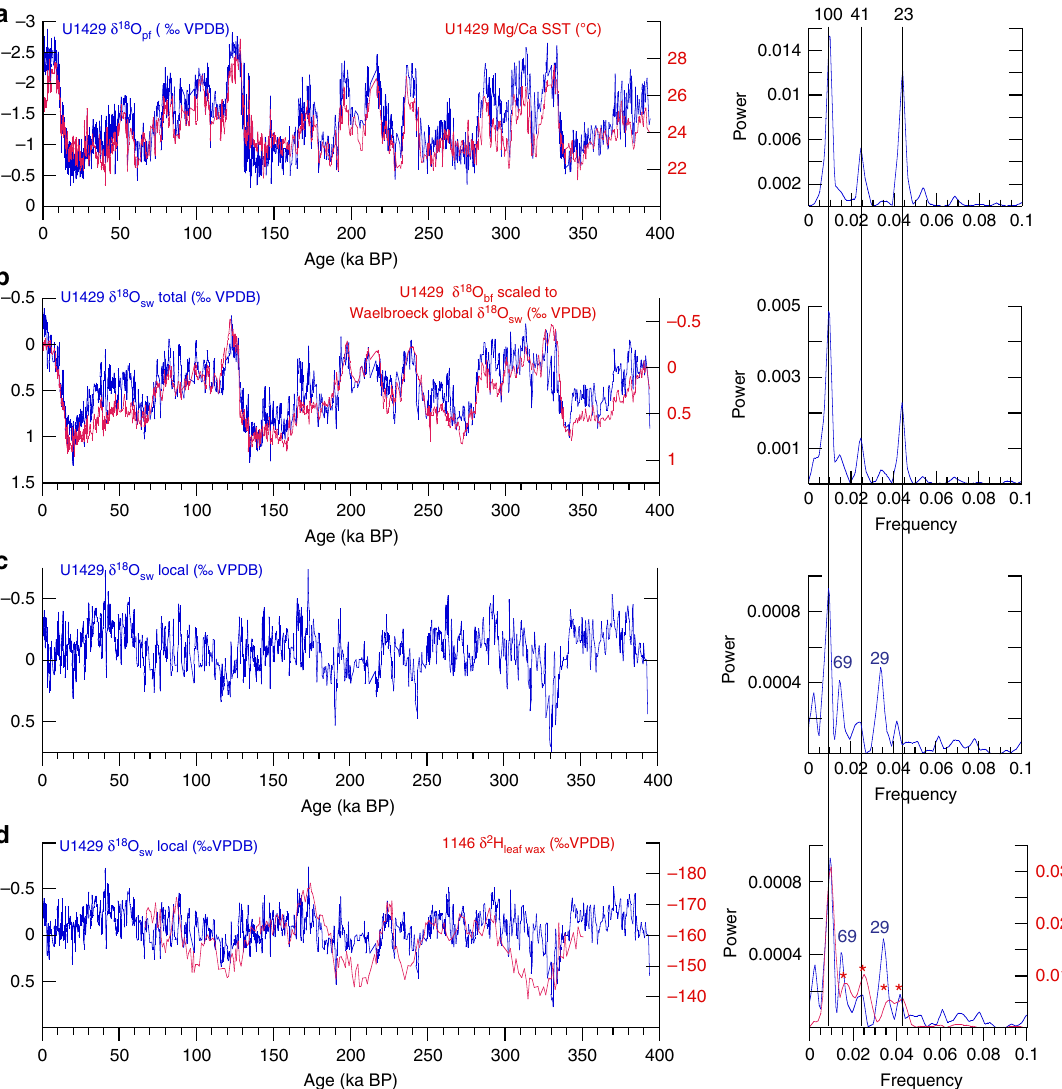
Fig. 4 Time series used in deriving local δ 18 O sw , and associated spectra. a U1429 δ 18 O pf (and spectrum) with Mg/Ca SST, both derived from G. ruber (250 – 355 μ m size fraction). b U1429 total δ 18 O sw (and spectrum) with U1429 δ 18 O bf scaled to match the global δ 18 O sw curve 74 ; this approach preserves the age model and high temporal resolution of the U1429 data. c , d U1429 local δ 18 O sw (and spectrum) with the Pearl River Valley δ 2 H wax record (and spectrum) from Site 1146 34 . Labeled dashed lines denote primary orbital frequencies (frequency = 1/period in ky). Orbital-scale peaks for frequencies <0.05 labeled with * do not meet the p = 0.05 threshold level for probability of chance occurrence